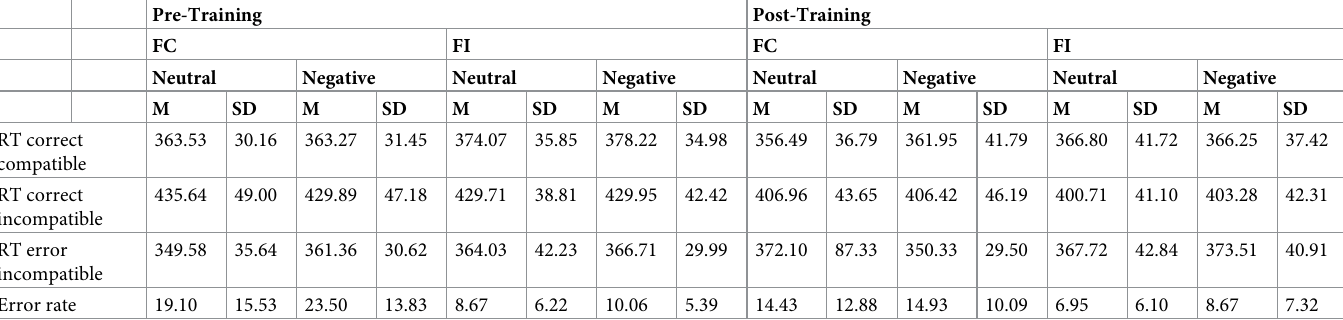
Table 2. Response times for correct responses in compatible and incompatible trials and error rates and error response times in incompatible trials after neutral and negative pictures in the FC and FI condition before and after training. Error rates are presented in % and response times are presented in ms.